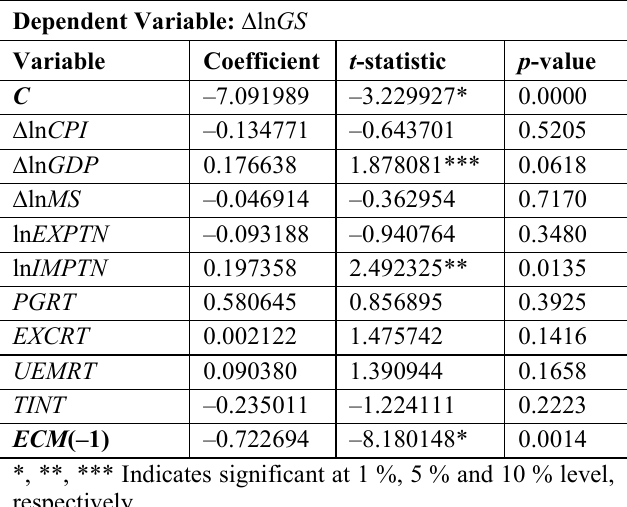
Table 5. Result of Short-Run ARDL Model